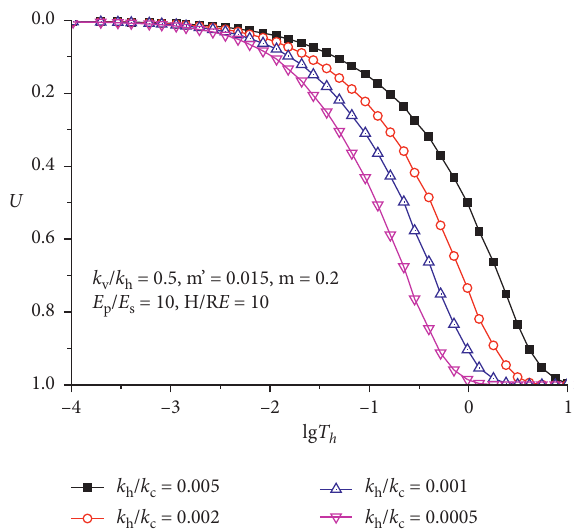
Figure 4: Influence of permeability coefficient of drainage board on foundation consolidation